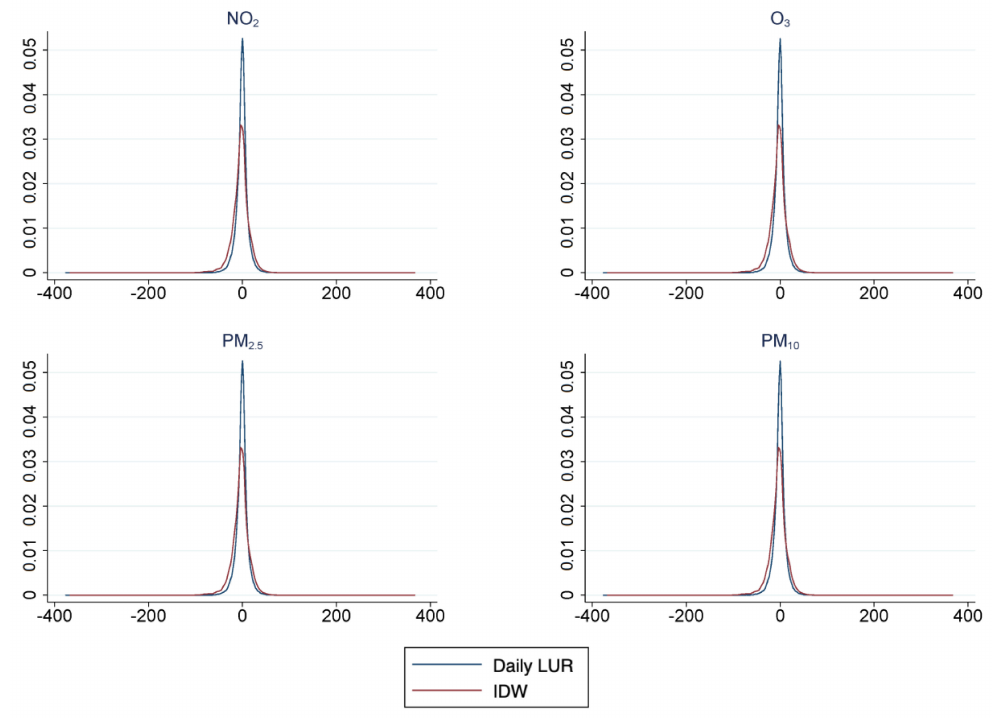
Figure A3. The density plots represent the differences between the daily LUR or IDW estimates and the air pollution concentration measured at monitoring stations, where the monitoring station itself has been removed from the calculation of the estimate.